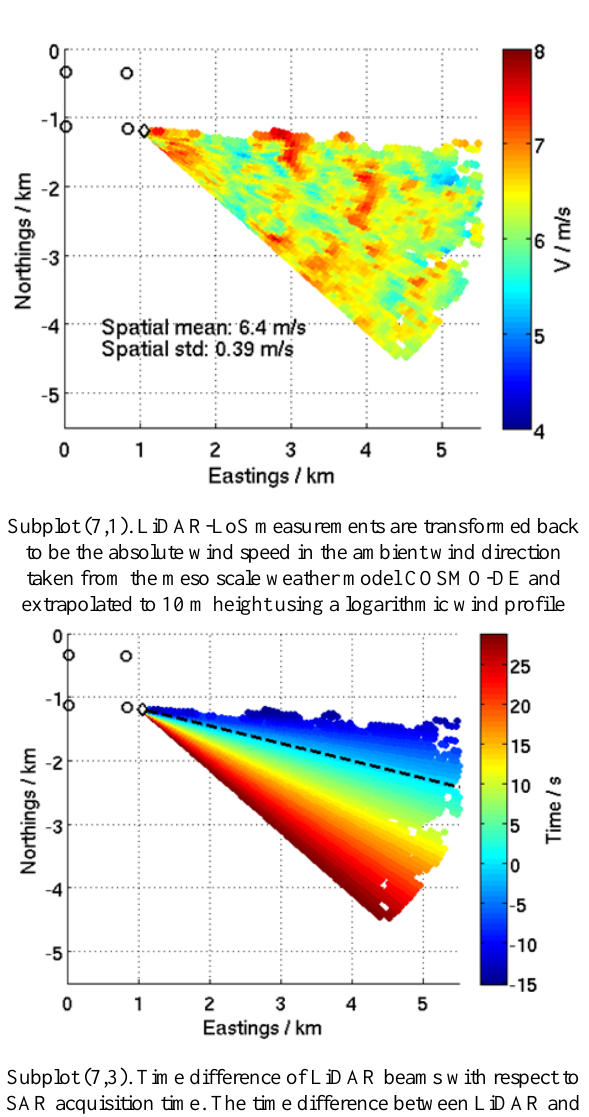
Figure 7. Absolute wind fields in 10 m height upstream of alpha ventus with south easterly wind conditions on the standard grid measured on the